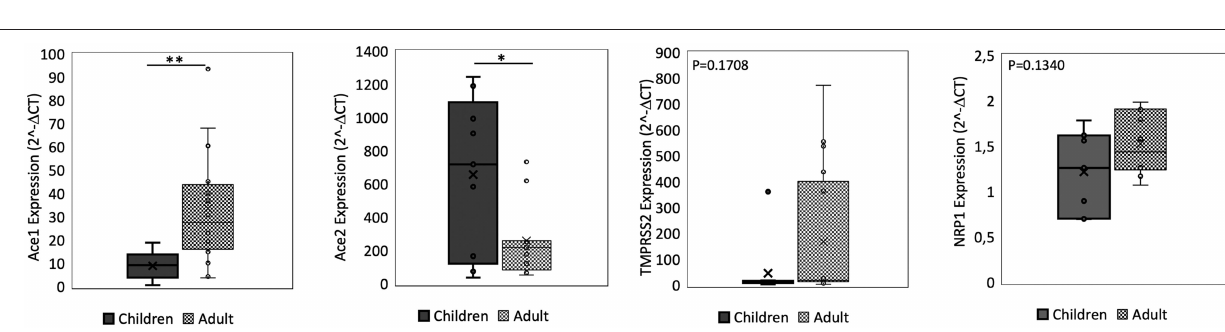
FIGURE 2 | qPCR analysis of Angiotensin I Converting Enzyme ( ACE1 ), Angiotensin II Converting Enzyme ( ACE2 ), Transmembrane Serine Protease 2 ( TMPRSS2 ), and Neuropilin-1 ( NRP1 ) genes in small intestine from children and adult subjects. Comparative expression of ACE1 , ACE2 , TMPRSS2 , and NRP1 in small intestine of children ( n = 15) and adult subjects ( n = 15). Data analysis was performed using the comparative threshold cycle (CT) method and expressed as 2 ∧ -delta CT. Gene expression was normalized against the expression of the reference gene hypoxanthine phosphoribosyltransferase 1 ( HPRT ). Data are expressed as median ± SD, the X in the bars indicates mean values. P -value are reported in the graphs; significant differences are indicated as * p < 0.01; ** p <